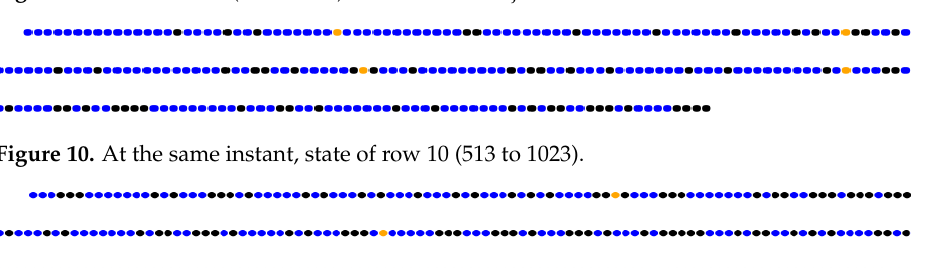
Figure 9. State of row 9 (257 to 511) when row 8 has just been finished.